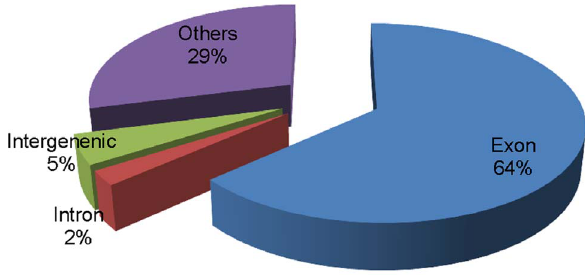
Figure 1. Distribution of reads from RNA-Seq.